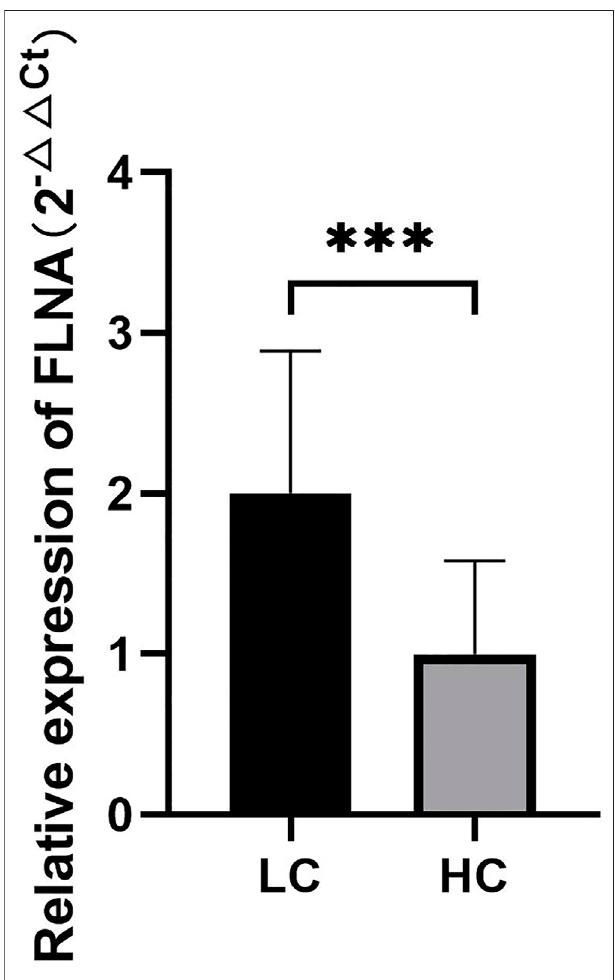
FIGURE 6 | The quantitative analysis results of FLNA gene expression in platelets of lung cancer patients and healthy subjects. *** p <